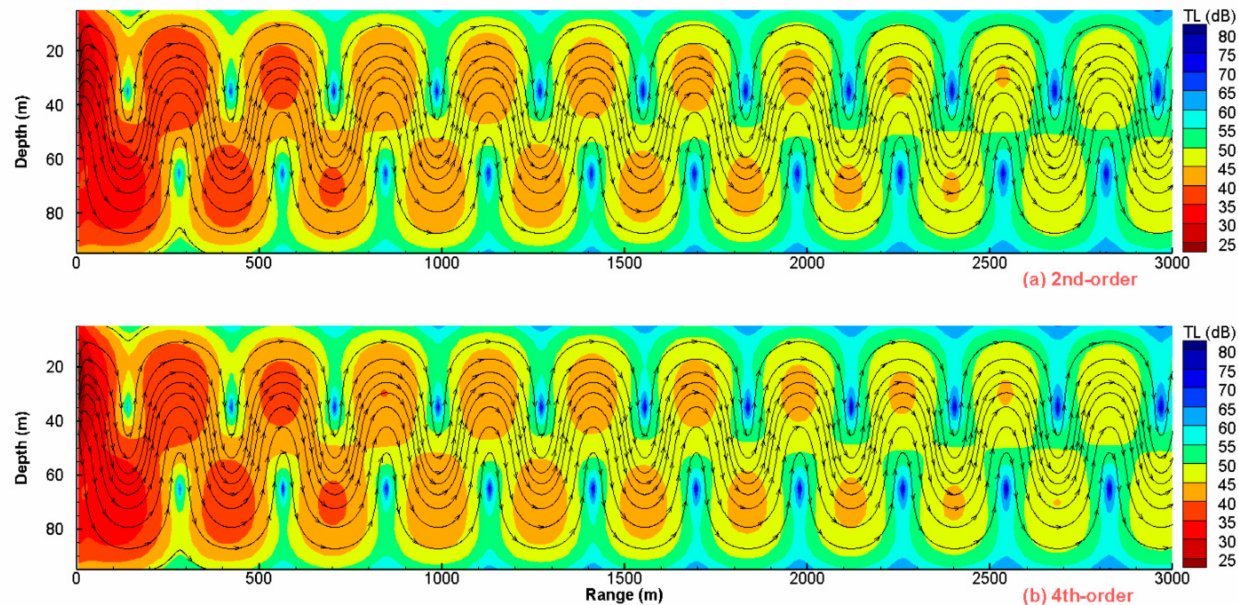
Figure 7. TL contours and TASI streamlines obtained from the VWI model for the ideal fluid waveguide using the 2nd-order FDM and the 4th-order